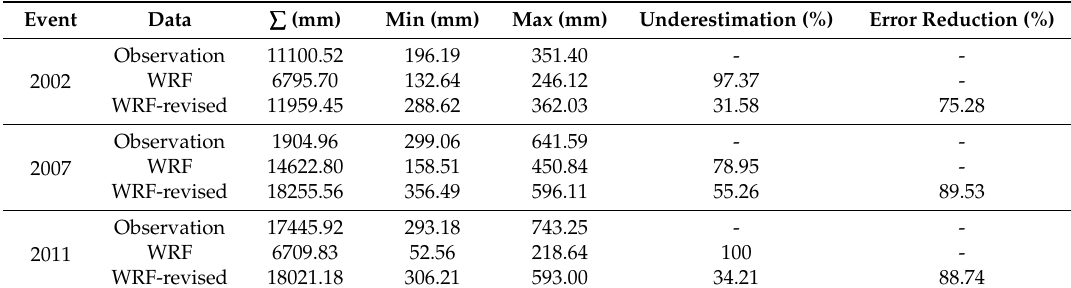
Table 4. Statistics of the MAP for the 2002, 2007 and 2011 flood events.